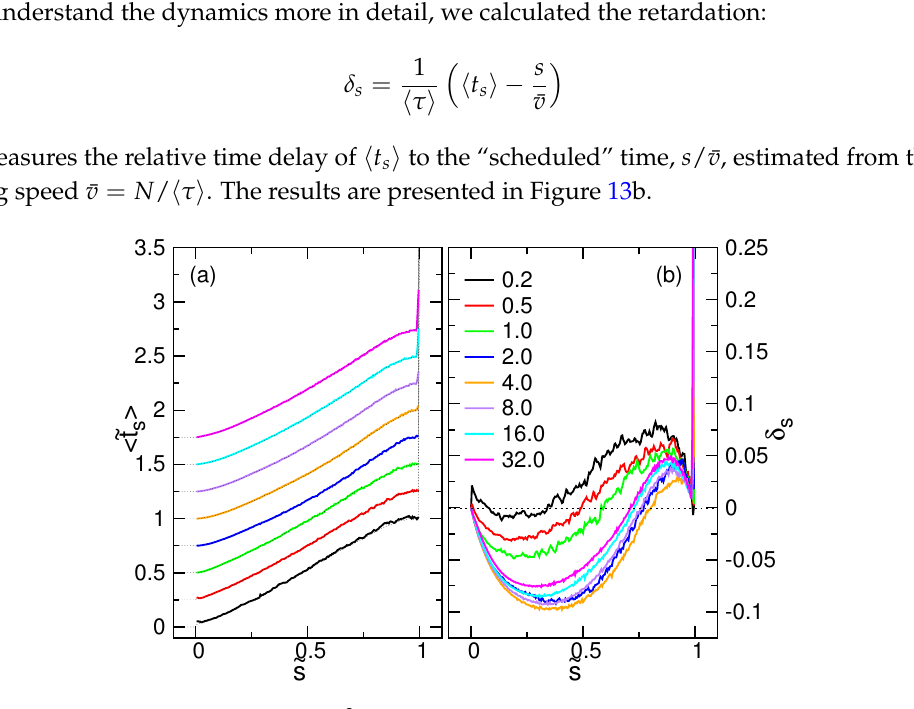
Figure 13. ( a ) (cid:104) ˜ t s (cid:105) calculated by µ s exp ( σ 2 s /2 ) , plotted in the scaled coordinate ˜ s at different E . For clarity, the curves have been shifted upward, one by one, by a fixed value. The strengths of E are indicated in the figure. The chain has 256 monomers. The dashed curves are the mean time obtained directly from the simulations, superimposed here for comparison. ( b ) Retardation δ s as a function of the scaled coordinate ˜ s